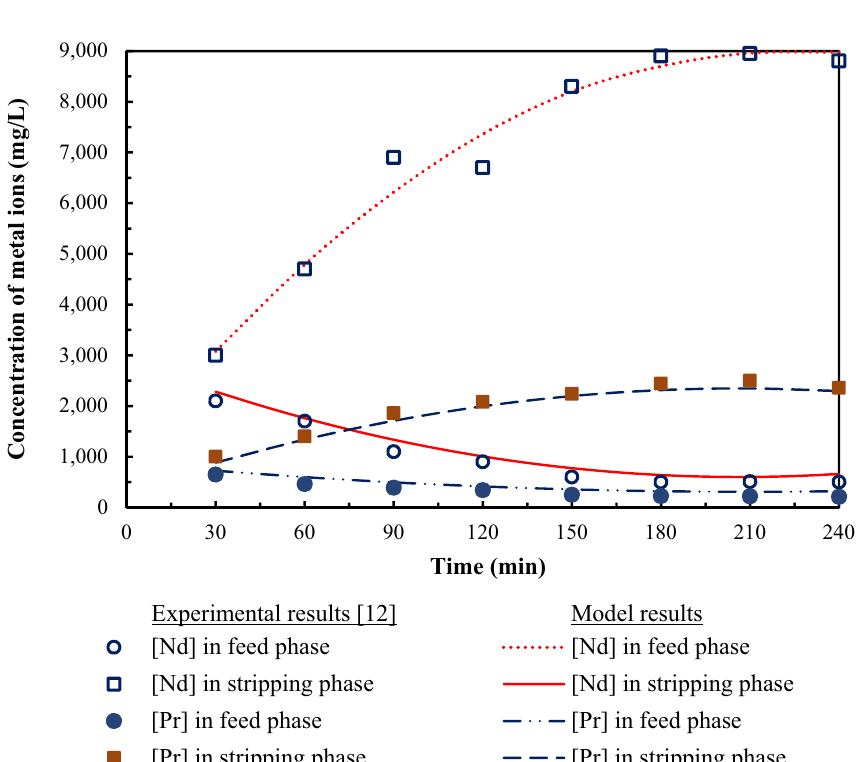
Figure 9. Adaptability of the mathematical model to predict the extraction and stripping of other metal ions via